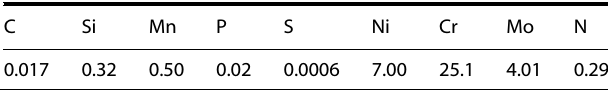
Table 2. Chemical composition of the duplex stainless steel (mass%).